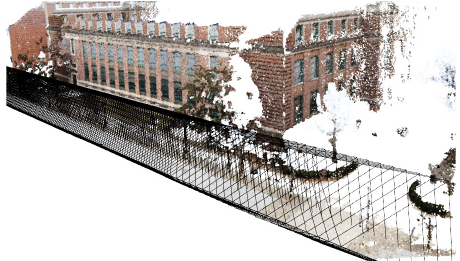
Figure 2. Reconstructed camera poses (black wireframes) and the generated 3D color point clouds from the street-view images. (b) Figure 1. (a): Green arrow is normal of the object point; black line represents surface determined by normal. (b): Green arrows are rays corresponding to the object point. Shadowed area represents possible area of surface implied by ray information.